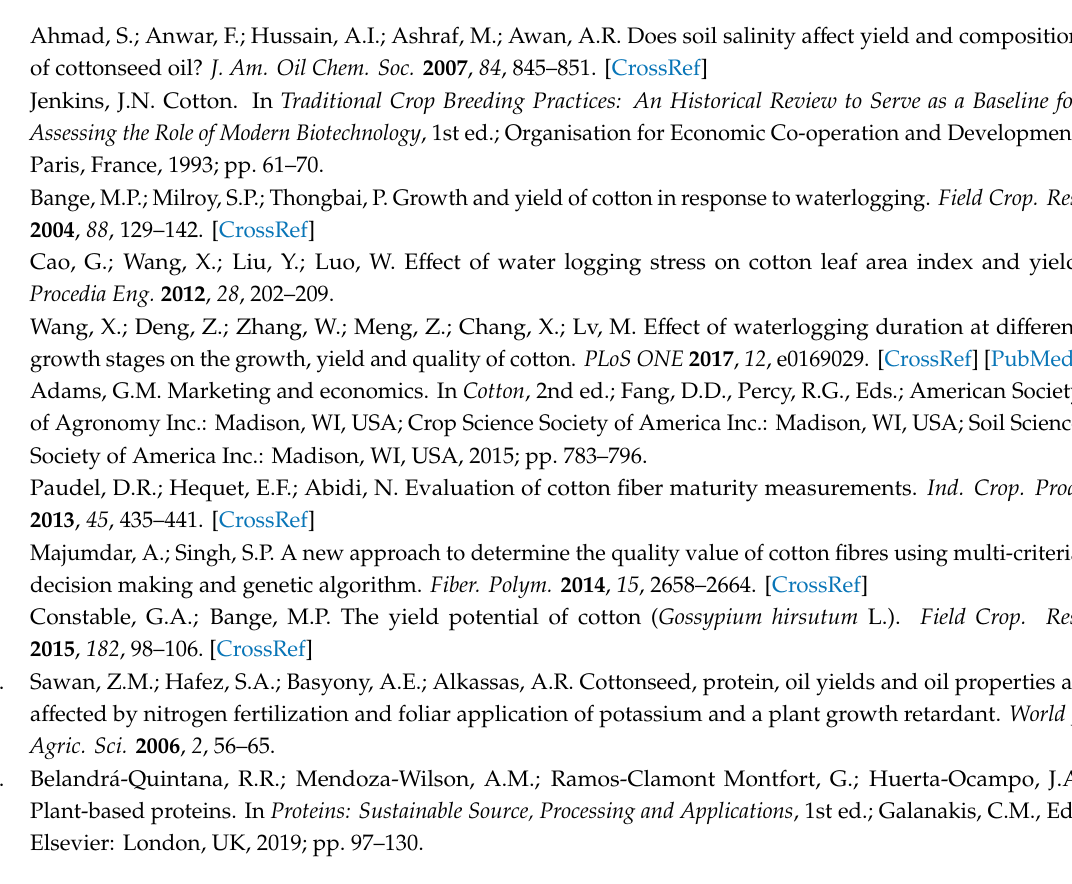
Figure S1: A view of “Piana di Gela Contrada Rinazzi” experimental field (ExpSt_1). Figure S2: A view of “Orleans” experimental field (ExpSt_2). Figure S3: Beginning of flowering stage at early sowing time (ExpSt_1). Figure